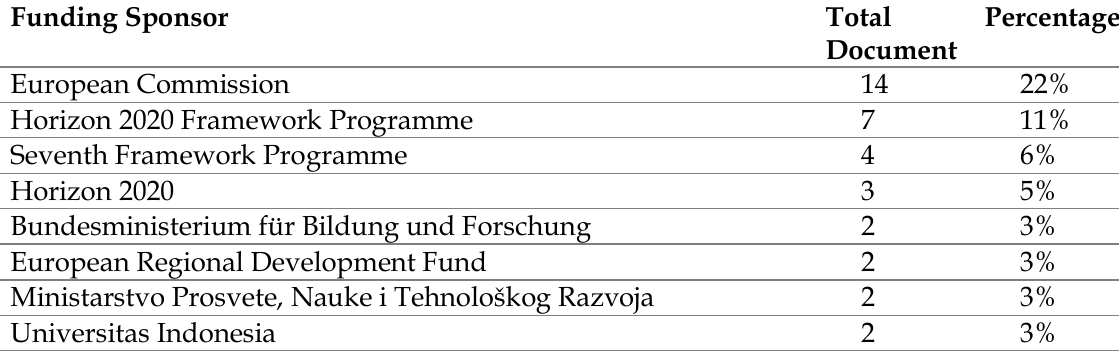
Table 4: Research Funding Interoperability E-Government. Source: Scopus